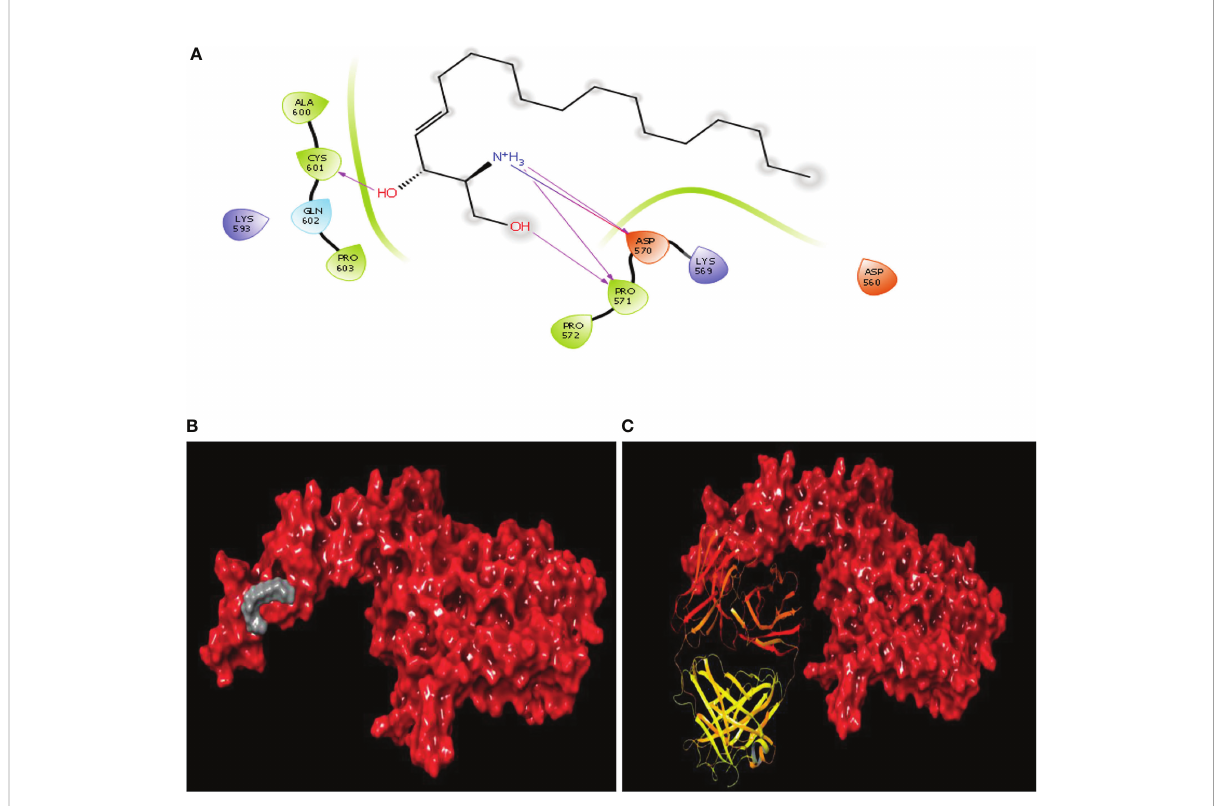
FIGURE 6 Binding site similarity of sphingosine and trastuzumab (A) interaction of sphingosine with extracellular site of HER2 (B) Binding pattern of sphingosine with extracellular pocket of HER2 (C) binding pattern of trastuzumab with extracellular pocket of HER2.